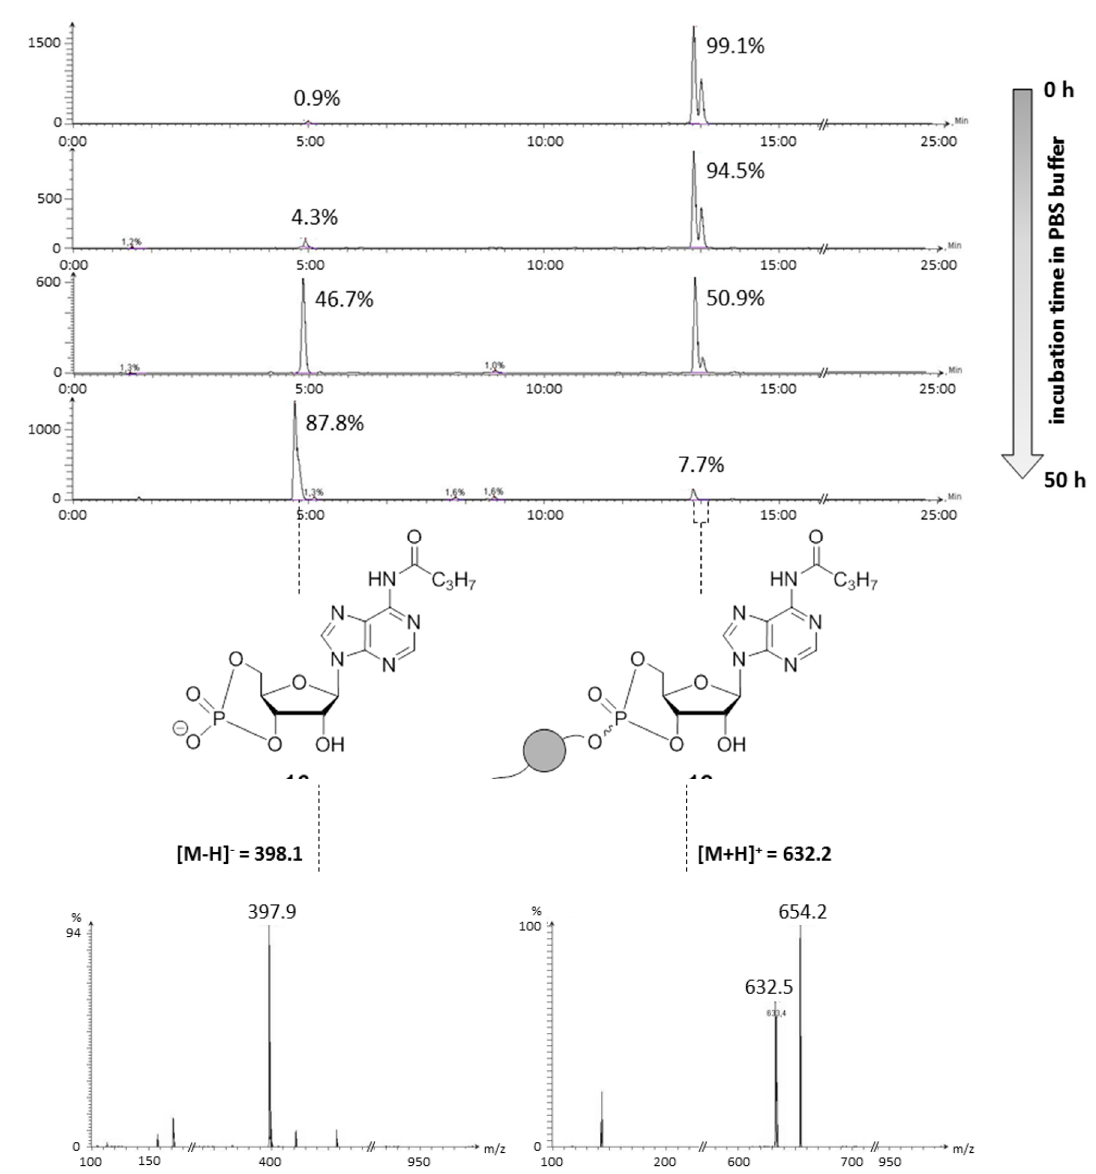
Figure 4. HPLC chromatograms and ESI mass spectra of the chemical hydrolysis of OB- N (Bu)-cAMP 12 in PBS (50 mM, pH 7.3) at 0 h, 1 h, 8 h, and 50 h. The two signals of the diastereomers vanished over time while the signal for N (Bu)-cAMP 15 increased. The compounds were assigned from the mass spectra recorded at the retention times coinciding with the signals found in the HPLC chromatograms.